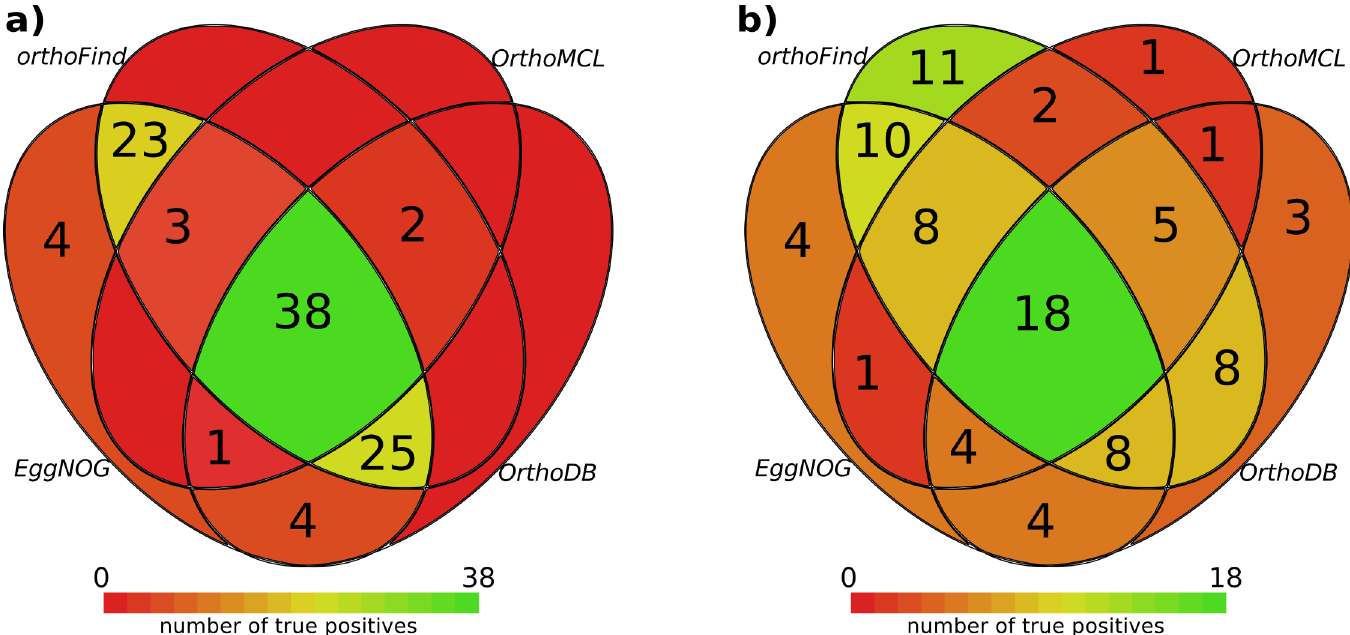
Fig 3. Overlap of the orthologs found between the different methods. a) Number of true positives found by the different methods, alone or jointly with some of the others. b) Number of true positives when unspecific results were removed (several orthologous candidates were predicted). The color scale highlights methods or groups of them with a high (green color) or low (red color) number of true positives. No number is shown if an individual method or group did not find any true